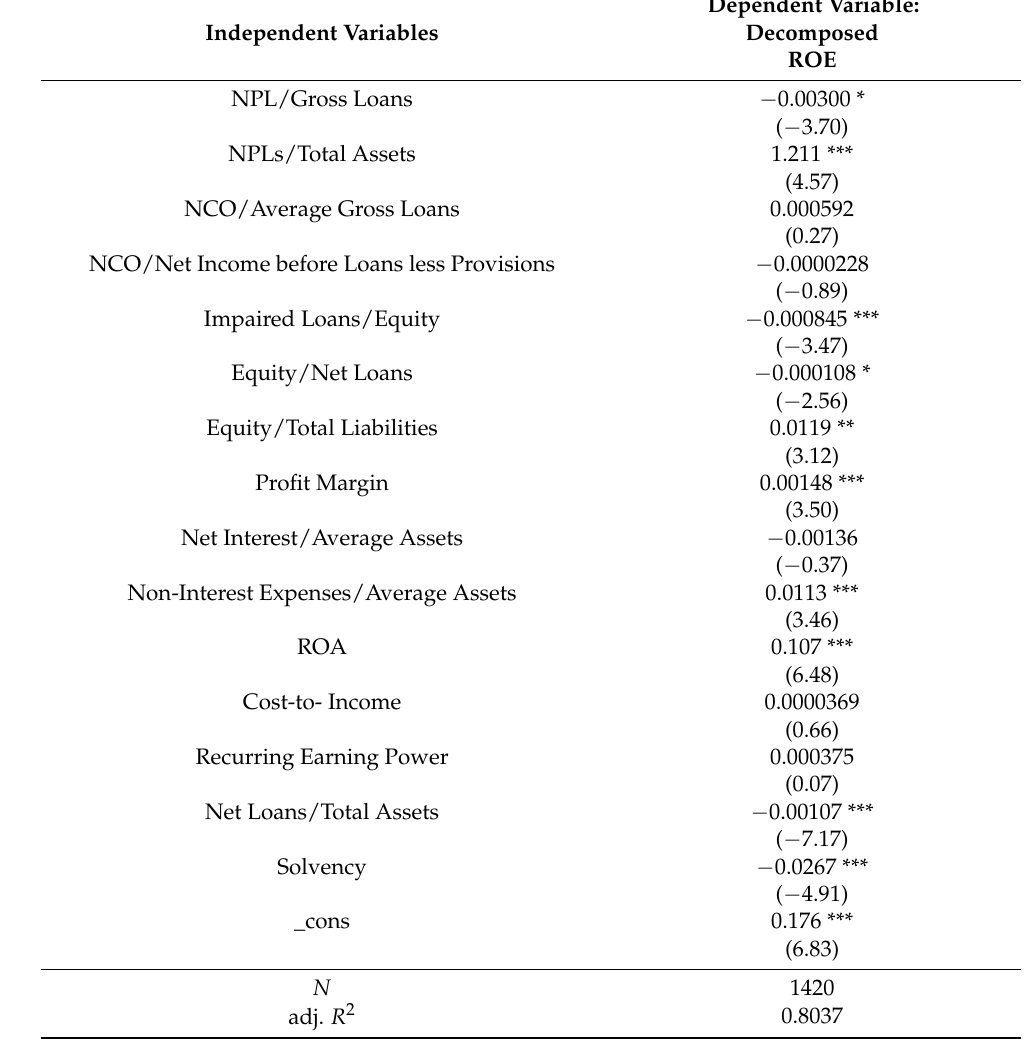
Table 3. Panel regression (with fixed effects for banks and years) for T(ROE) discovery. We considered decomposed ROE (measured as addressed by ECB (2010)) as the dependent variable and ratios describing the major characteristics of the business of the banks as independent variables (directly extracted from ORBIS). The complete sample is made up of 142 Italian banks and the time span is from 2011 to